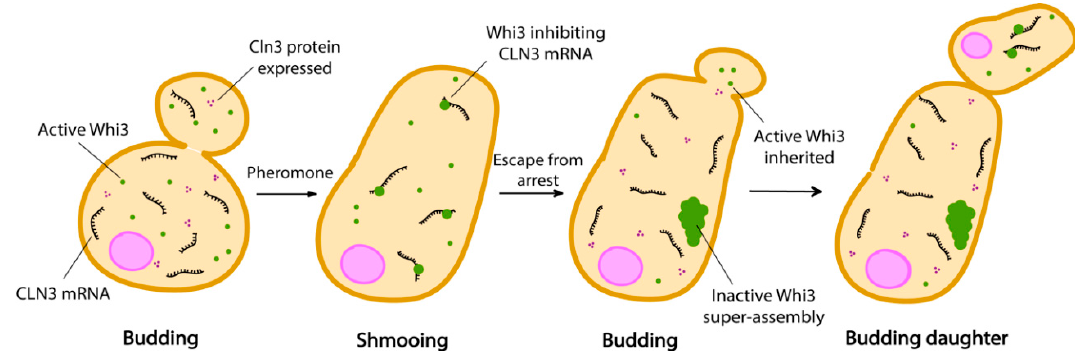
Figure 3. The pheromone refractory state in budding yeast is propagated by Whi3 super-assembly formation. Cln3 protein expression is constitutive when CLN3 mRNA is free from inhibition. Inactive Whi3 is confined in the mother cell, while daughter cells containing active Whi3 continue to shmoo.